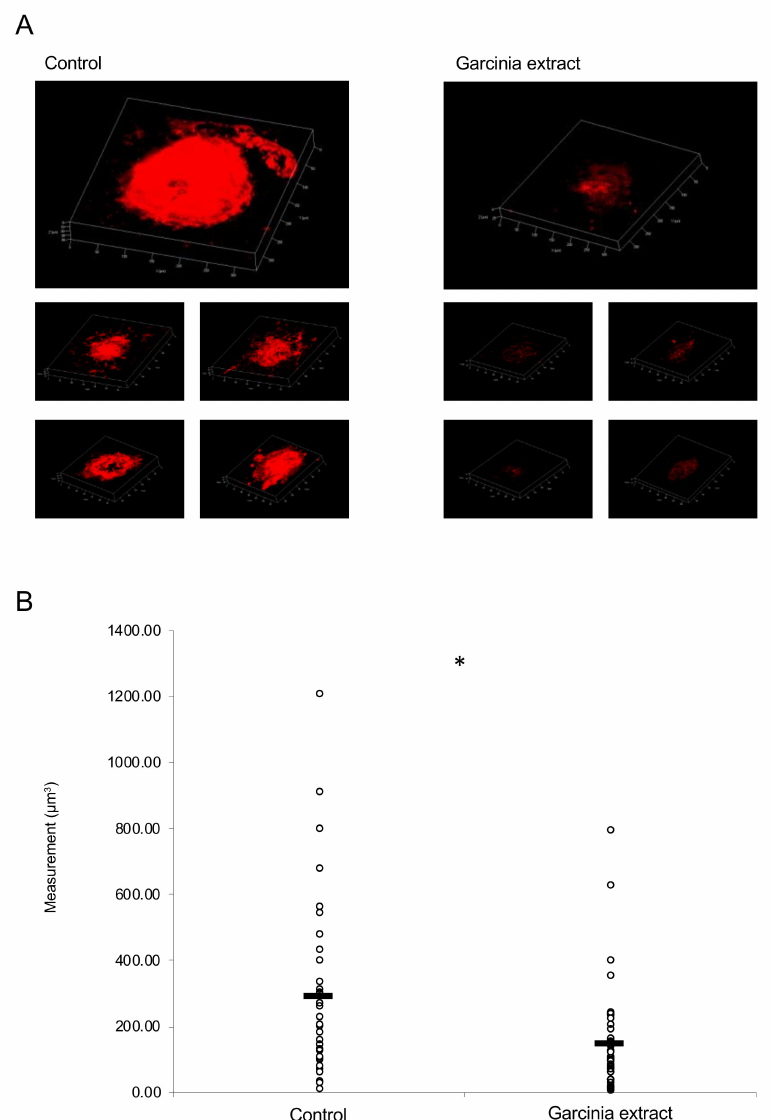
Figure 5. Administration of Garcinia extract suppressed choroidal neovascularization (CNV) volume in mice. ( A ) Representative three-dimensional images of isolectin B4 (IB4)-stained CNV. Individual CNV from each mouse was shown. ( B ) Quantification of the laser-induced CNV volume. Note that the administration of Garcinia extract significantly reduced the CNV volume when compared with the control group. Control: 248.09 ± 262.52 µ m 3 , Garcinia extract: 151.58 ± 152.96 µ m 3 , n = 44 for each, 5 mice for each, * p <